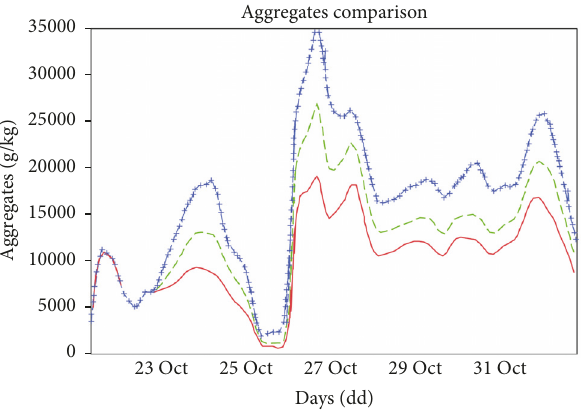
Figure 5: Plot of aggregates for the different sensitivity experiments; red: a1d1, green: a1d3, blue: